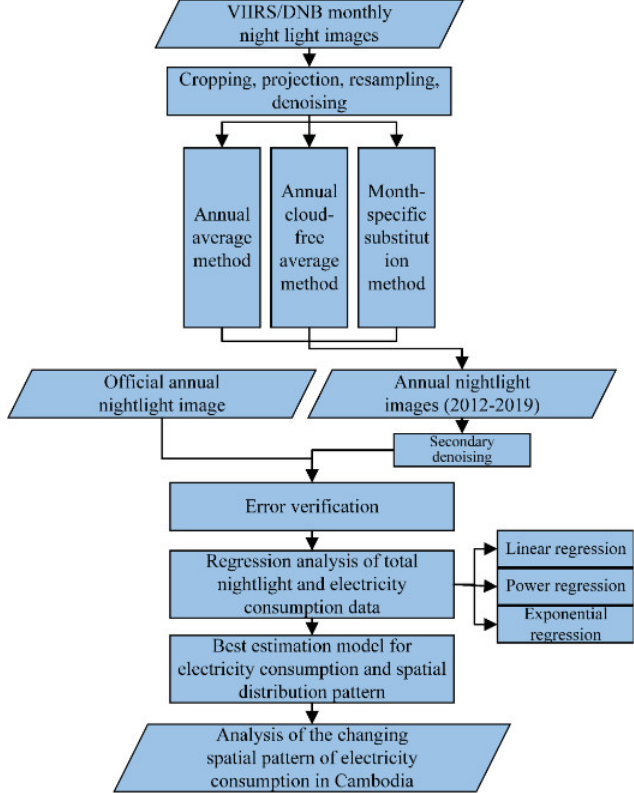
Figure 1. Flowchart of the research process used in the present study.